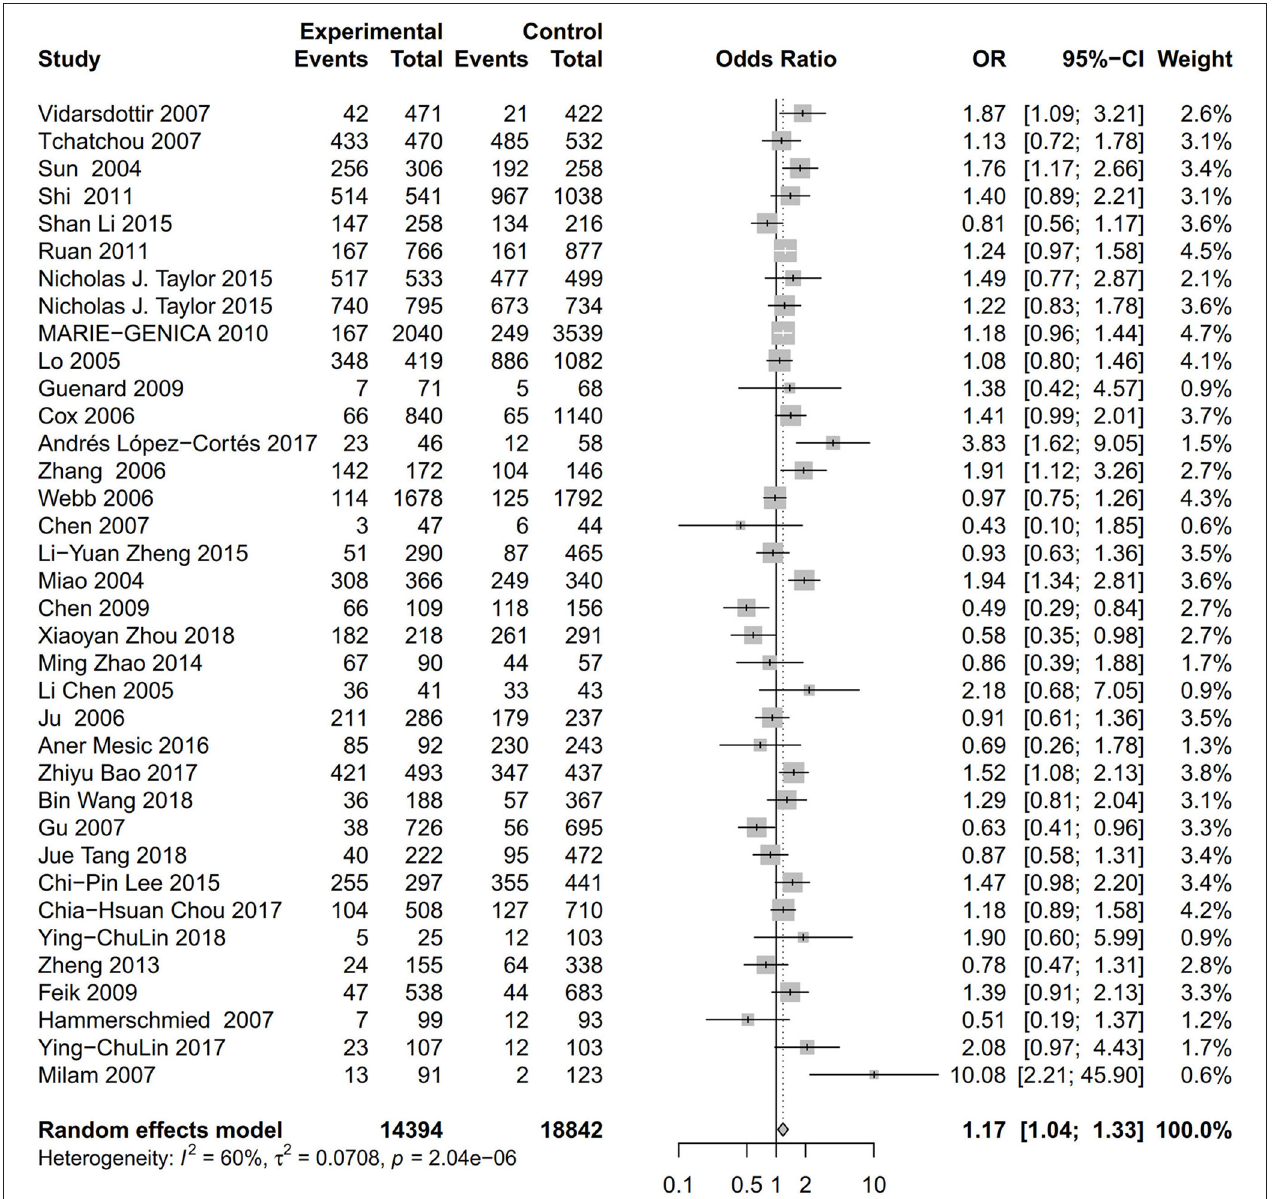
FIGURE 3 | Forest plot of the association between the AURKA rs2273535 T > A polymorphism and overall cancer risk under the homozygous model (AA vs. TT).